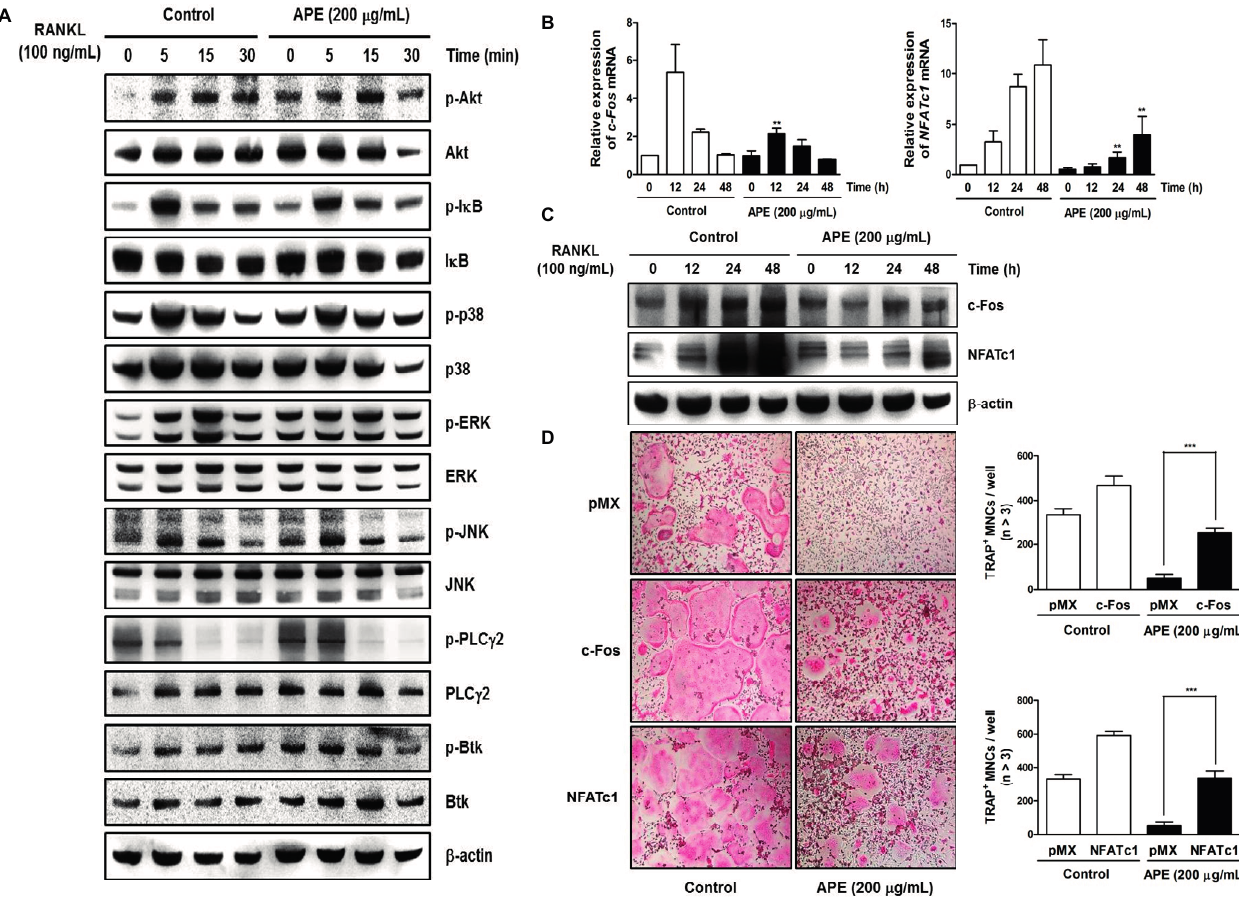
* : p < 0.05; ** : p < 0.01; *** : p <